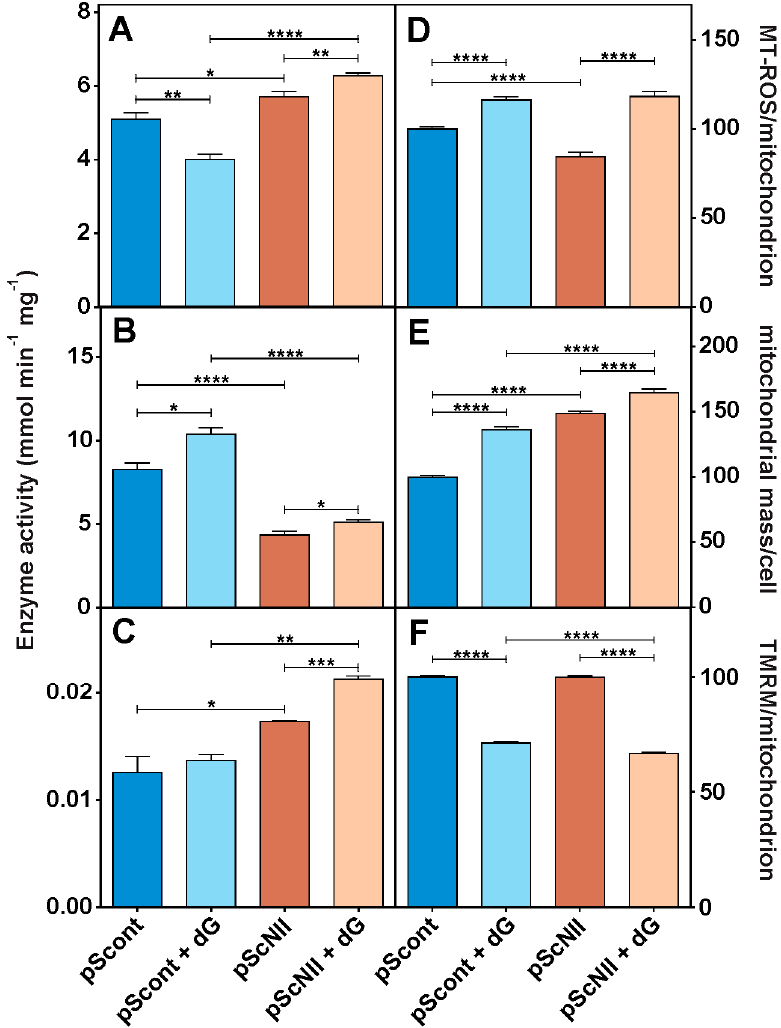
Figure 4. Effect of cN-II silencing on enzyme activities, mitochondrial ROS, mass and membrane potential in A549 cells. ( A ) LDH, ( B ) hexokinase and ( C ) CS were assayed as described in Materials and Methods in cell extracts obtained from cultured pScont and pScNII incubated 24 h with or without 20 mM dG. Each experiment was performed in triplicate and repeated at least three times; ( D ) mitochondrial ROS; ( E ) mitochondrial mass; ( F ) mitochondrial potential. The analysis was performed with confocal microscopy as described in Material and Methods in pScont and pScNII cells incubated for 24 h in the presence or absence of 20 mM dG. Data are the average + SEM of three independent experiments. * p < 0.05, ** p < 0.01, *** p < 0.001, **** p < 0.0001.